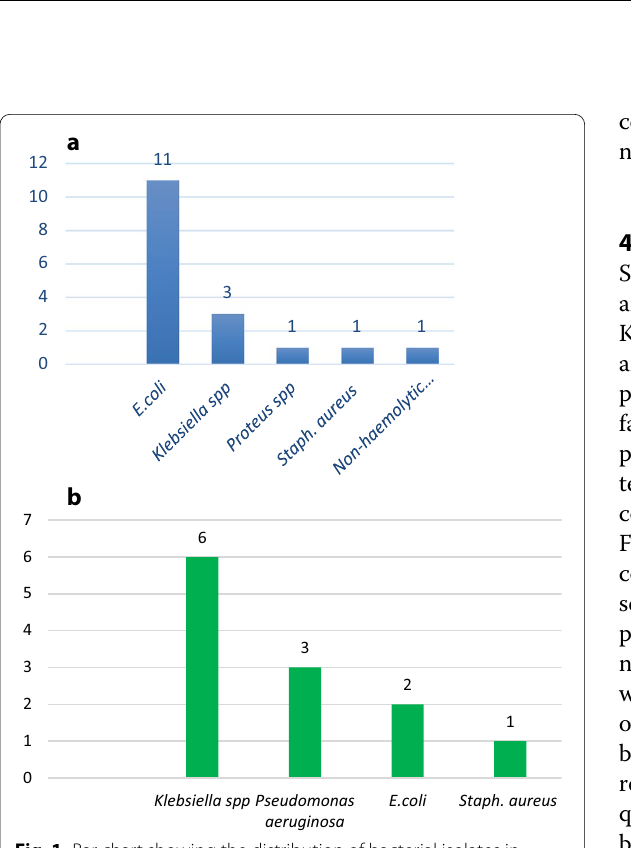
Fig. 1 Bar chart showing the distribution of bacterial isolates in group 1 (blue) and group 2